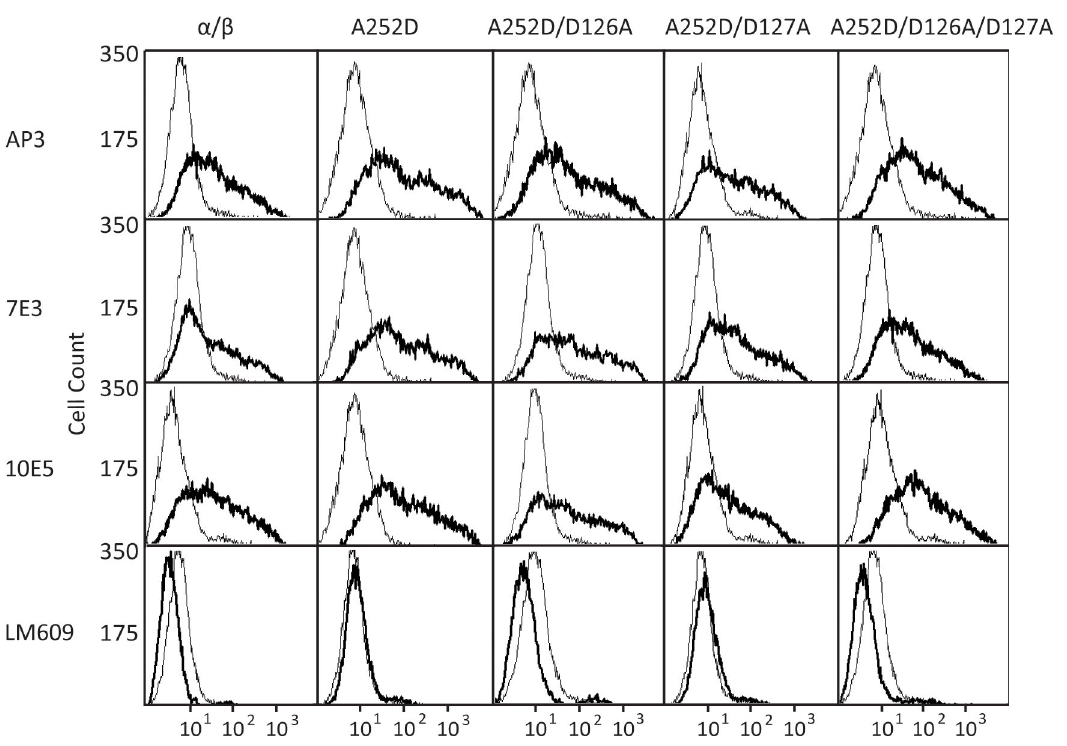
Figure 2. Expression of WT and Mutant αIIbβ3 Integrins. Immunofluorescent flow cytometry. HEK293T transfectants were labeled with AP3 (anti-β3), 7E3 (anti-β3), 10E5 (anti-αIIb), and LM609 (anti-αV). Thick and thin lines show labeling of the αIIbβ3 transfectant and the mock transfectant,